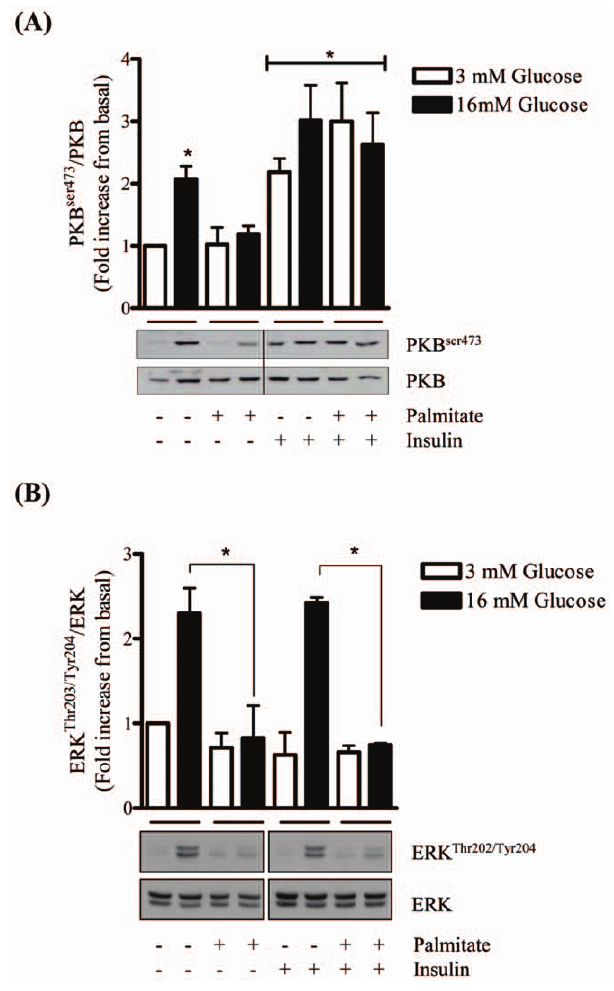
Figure 4. Palmitate does not inhibit PKB activation in response to exogenously added insulin but does prevent glucose- induced activation of ERK. MIN6 b cells were incubated in the absence or presence of palmitate (0.4 mM) for 48 h. Glucose (16 mM) was added for 1 h and insulin (100 nM) in the penultimate 10 min of this incubation period. Cells were harvested and immunoblotted for phospho-PKB Ser473 (A) and phospho-ERK Thr202/Tyr204 (B) and normalised against total protein. Bars represent mean 6 SEM from 3 separate experiments and asterisks signify a significant difference from the untreated control values (P ,